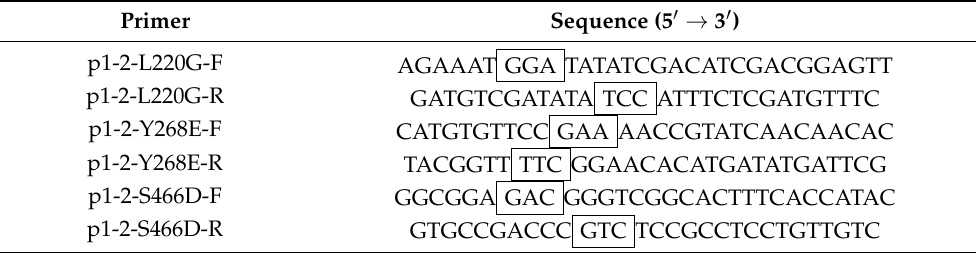
Table 2. Primers used for construction of lxyl-p1-2 variants. Primer Sequence (5 (cid:48) → 3 (cid:48)